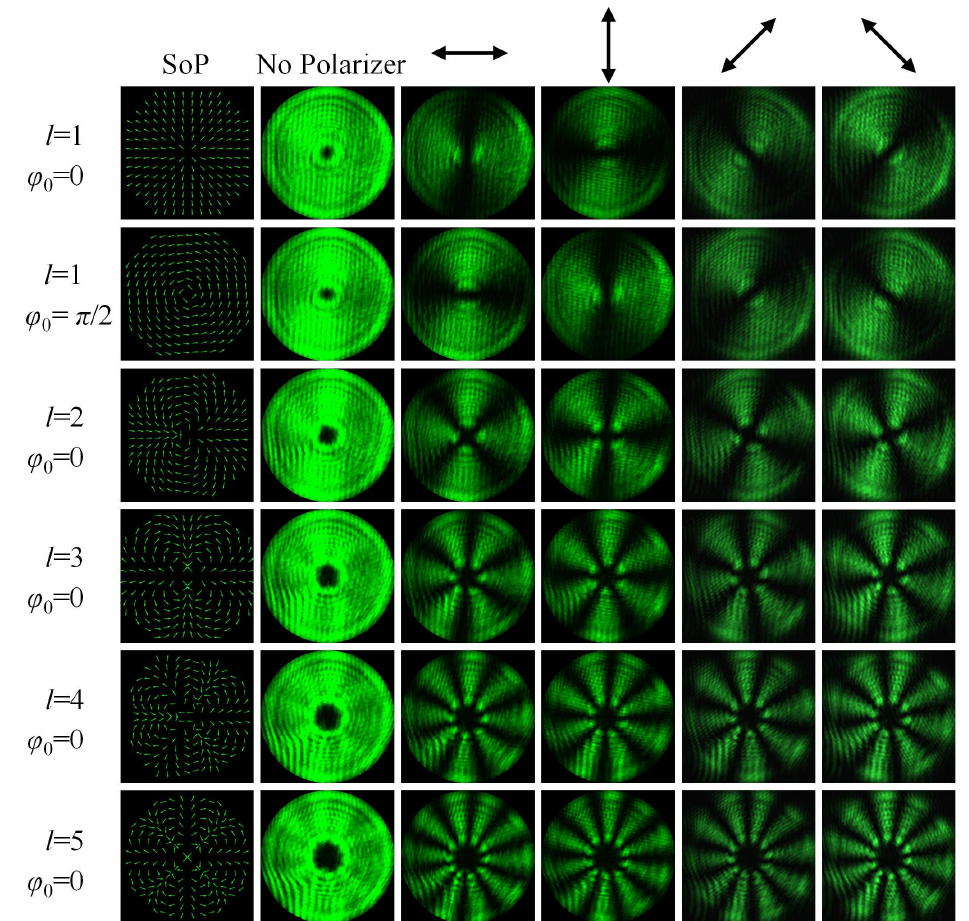
Figure 4. Generated vector beams with topological charges of l = 1, 2, 3, 4 and 5, respectively. The first two rows correspond to RP beam and AP beam for φ 0 = 0 and π /2. The first column represents the theoretical SOPs distribution of different vector beams. The second, third, fourth, fifth and sixth columns represent the intensity patterns of the vector beams after inserting no polarizer, horizontal polarizer, vertical polarizer, 45° polarizer and 135° polarizer, respectively.